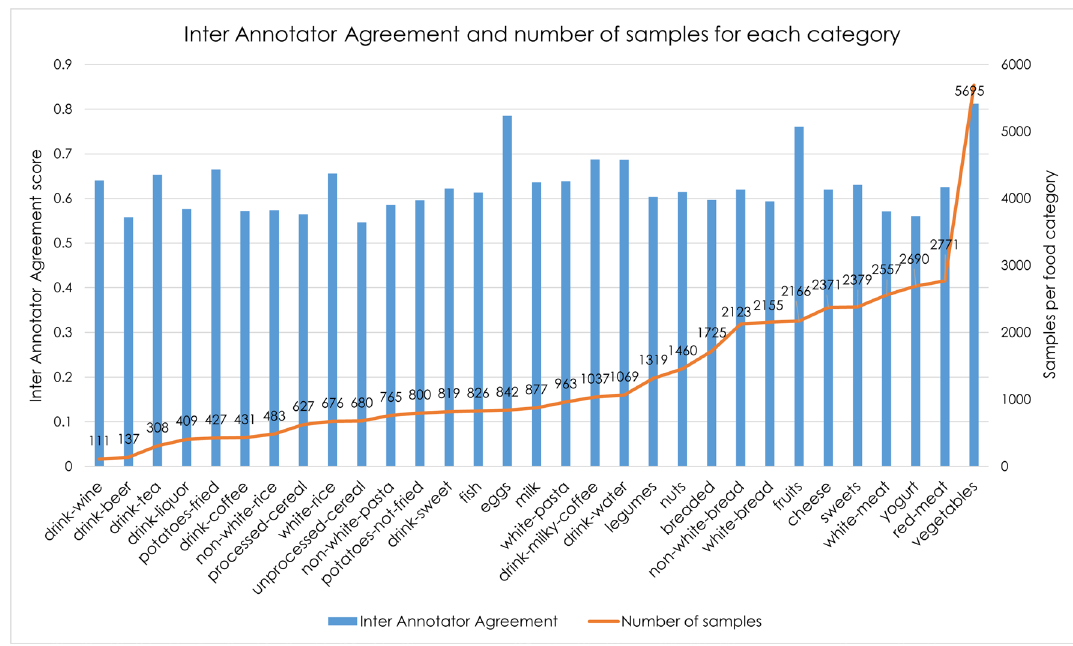
Figure 2. Inter annotator agreement ( IAA c ) for each of the 31 food categories, ranked from the category that has the fewest samples in the training set (wine) to the one that has the most